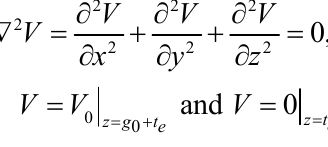
Figure 3. Distribution of displacement vertical component along x-coordinate predicted by coupled EM-thermal analysis followed by a coupled thermal-structural analysis for corrugated aluminum RF MEMS switch membrane ( l